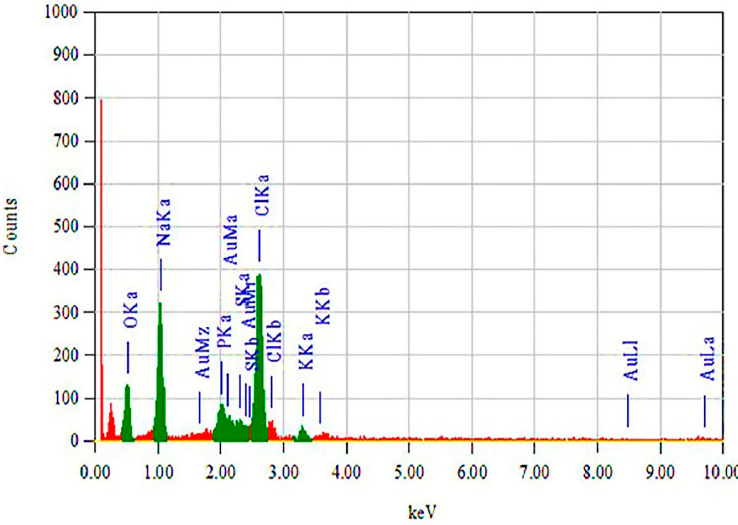
Figure 7. EDS analysis (EDXA) of FAuNPs.